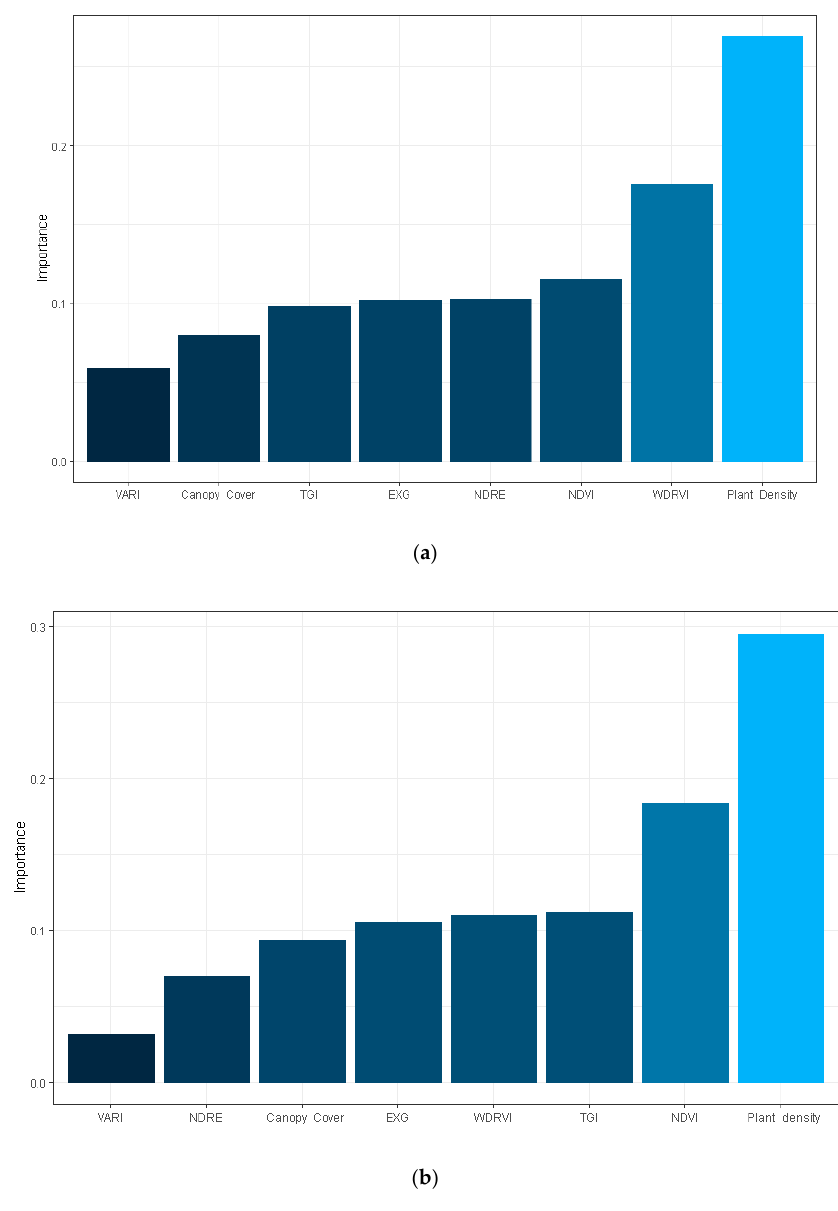
Figure 9. Relative importance of the predictors in the corn grain yield estimation. ( a ) Relative importance of the predictors for the 47 DAS; ( b ) relative importance of the predictors for the 79